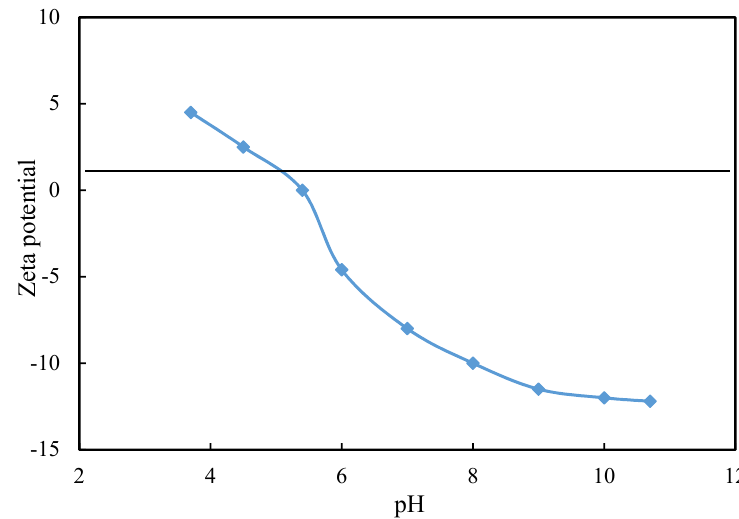
Figure 11. Zeta potential of apatite as a function of pH (after [16]).